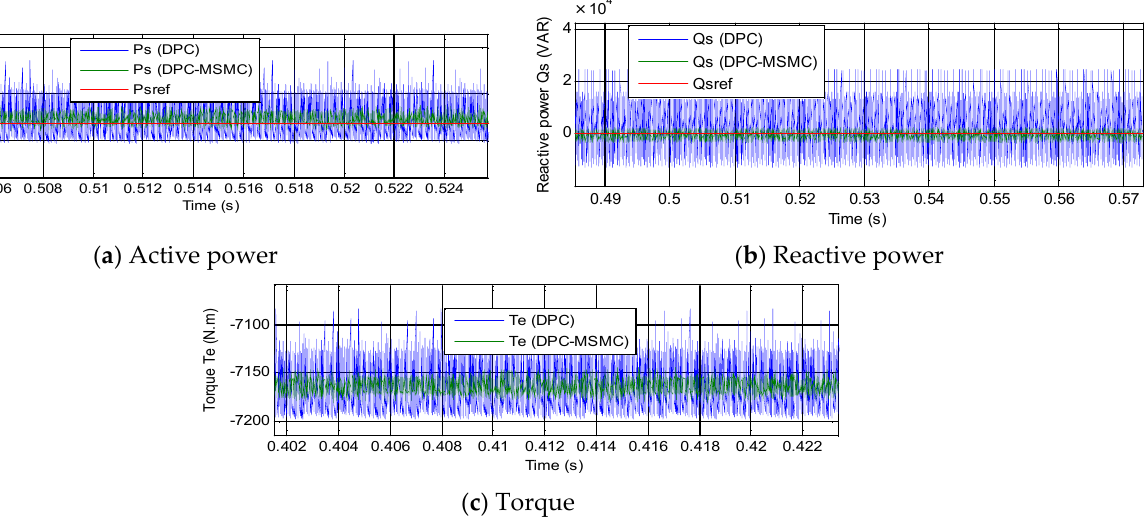
Figure 8. Zoom in the reactive power, torque, and active power (steps speed wind test).